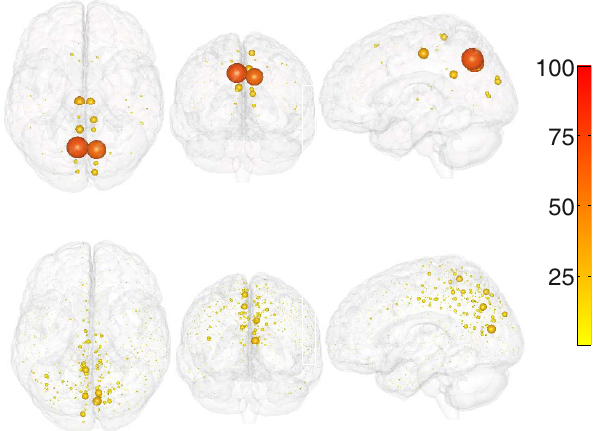
Figure 5. The average time between two consecutive spin flips across the different brain areas. 66-nodes and 998-nodes